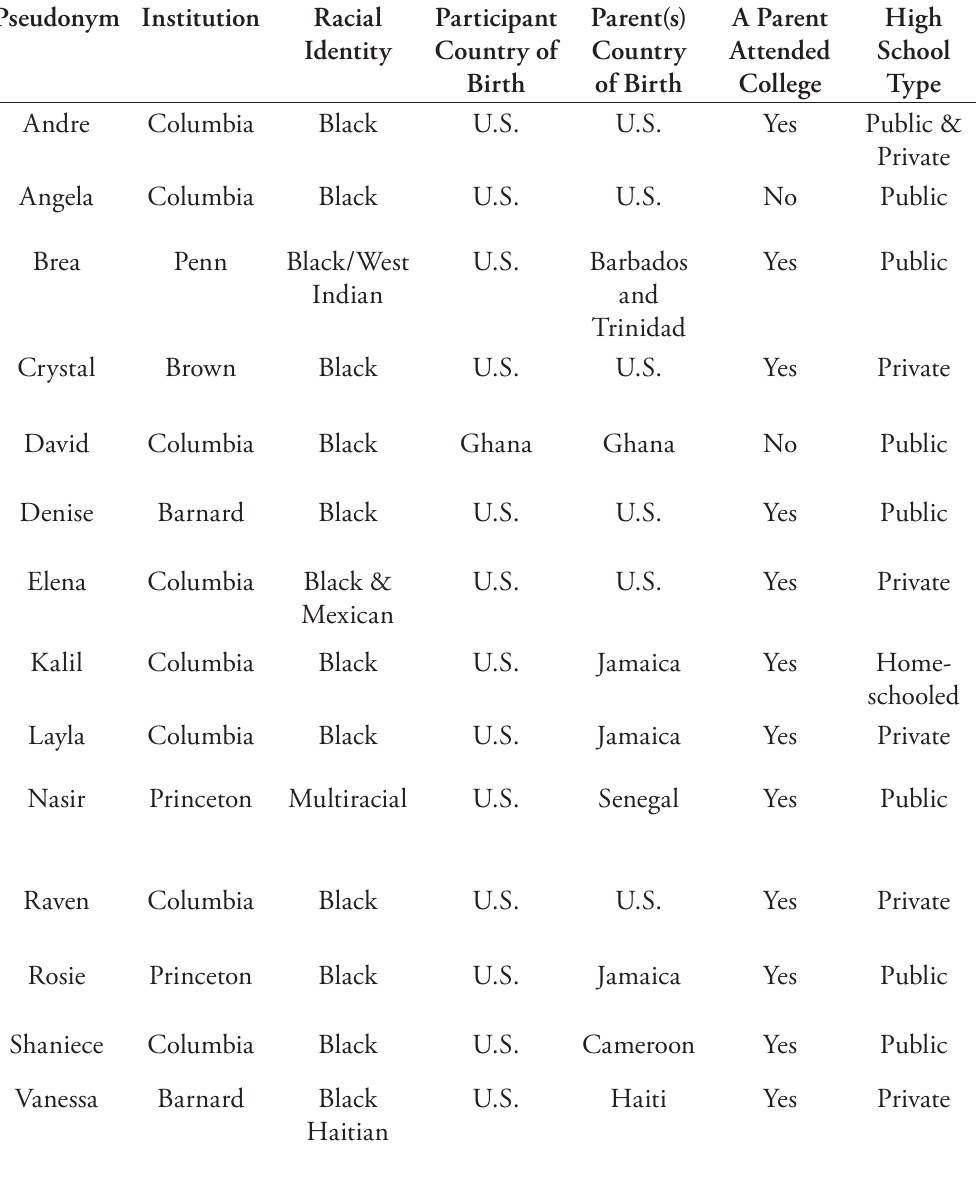
Table 1: Summary of Participant Demographic Information Pseudonym